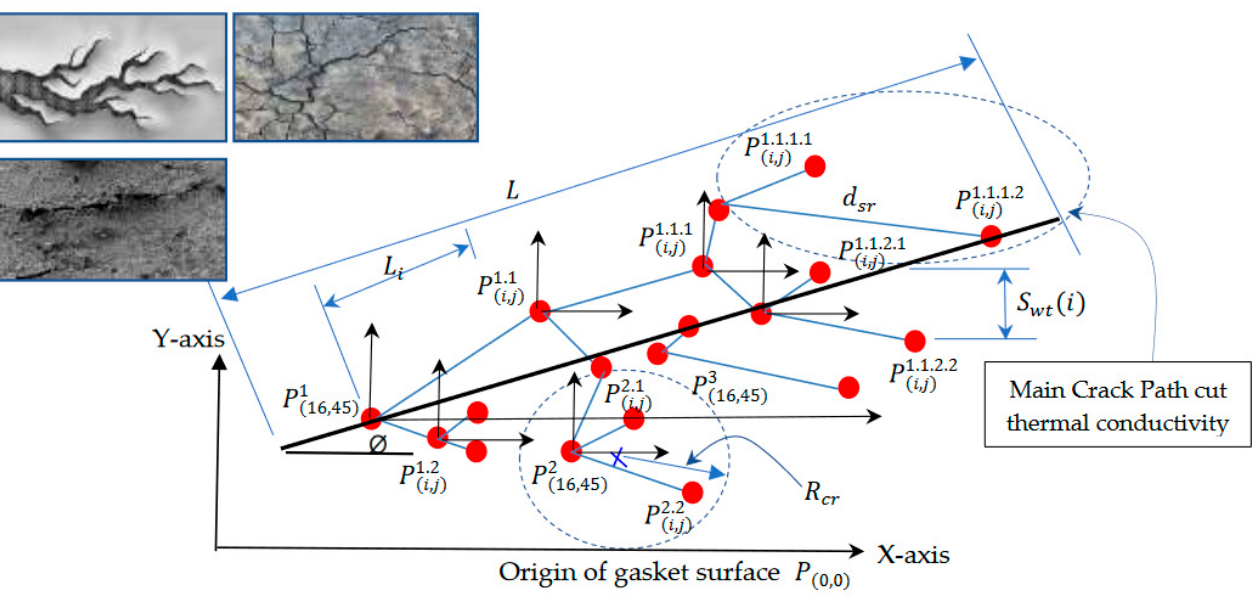
Figure 4. A hypothetical visualization of the appearance and growth of cracks and how to track them. The crack position; represent the coordinates; dimension arrows